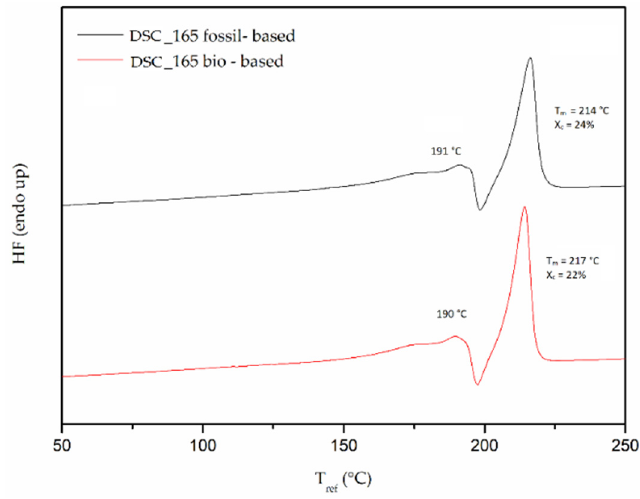
Figure 7. DSC curves of microscale DSSP products at 165 °C.